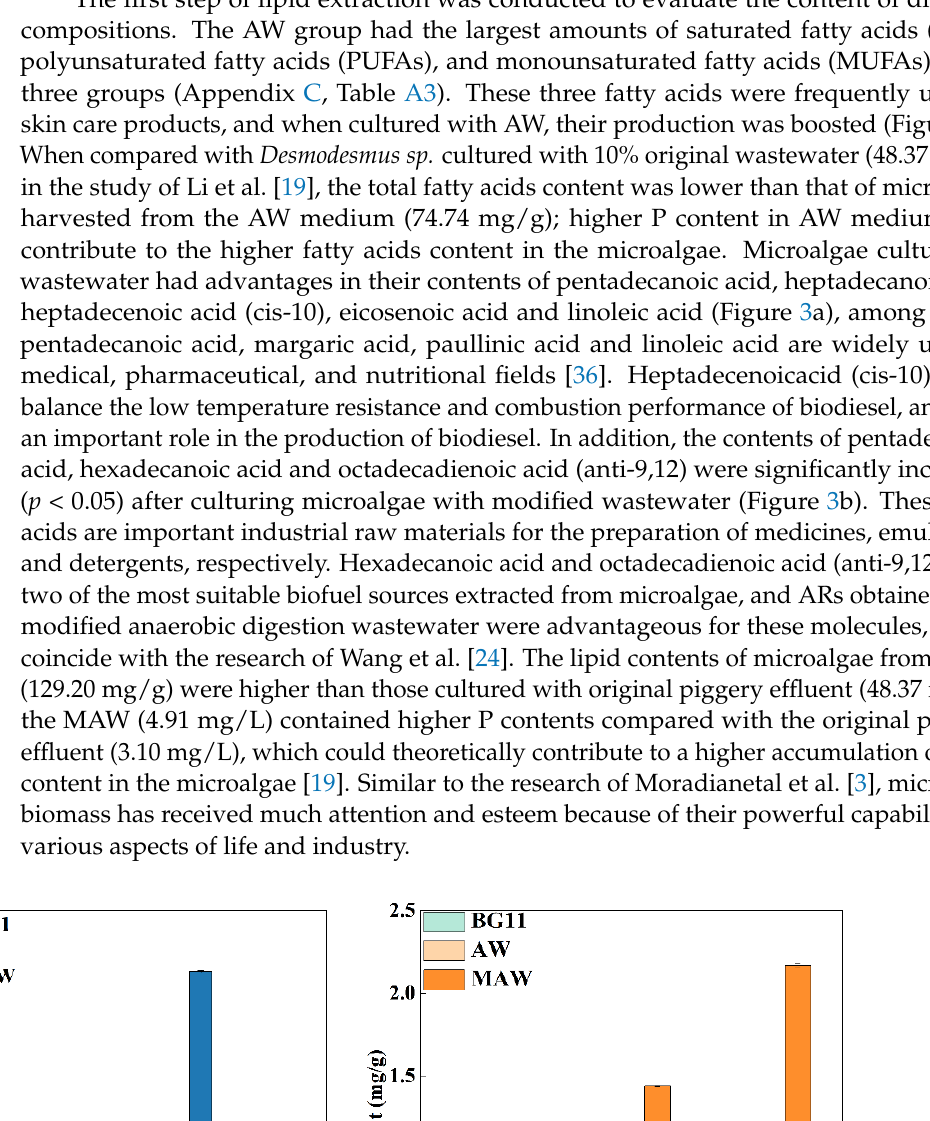
Figure 2. Lipid contents of three kinds of microalgae (obtained from BG11, AW and MAW medium, respectively).